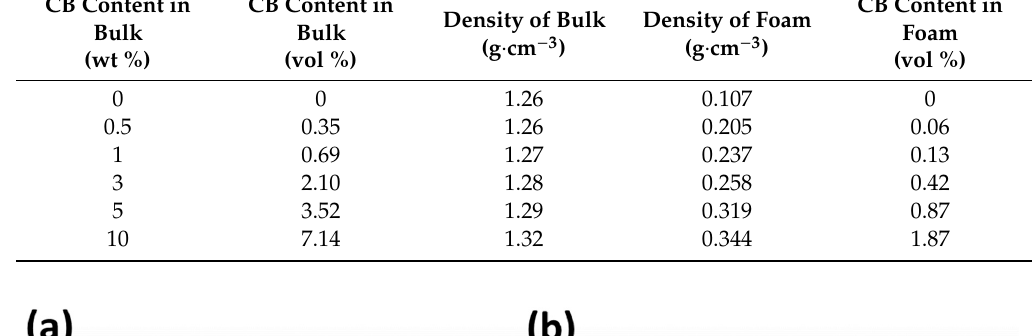
Table 2. Density values of PBS/CB nanocomposites and nanocomposite foams with different CB